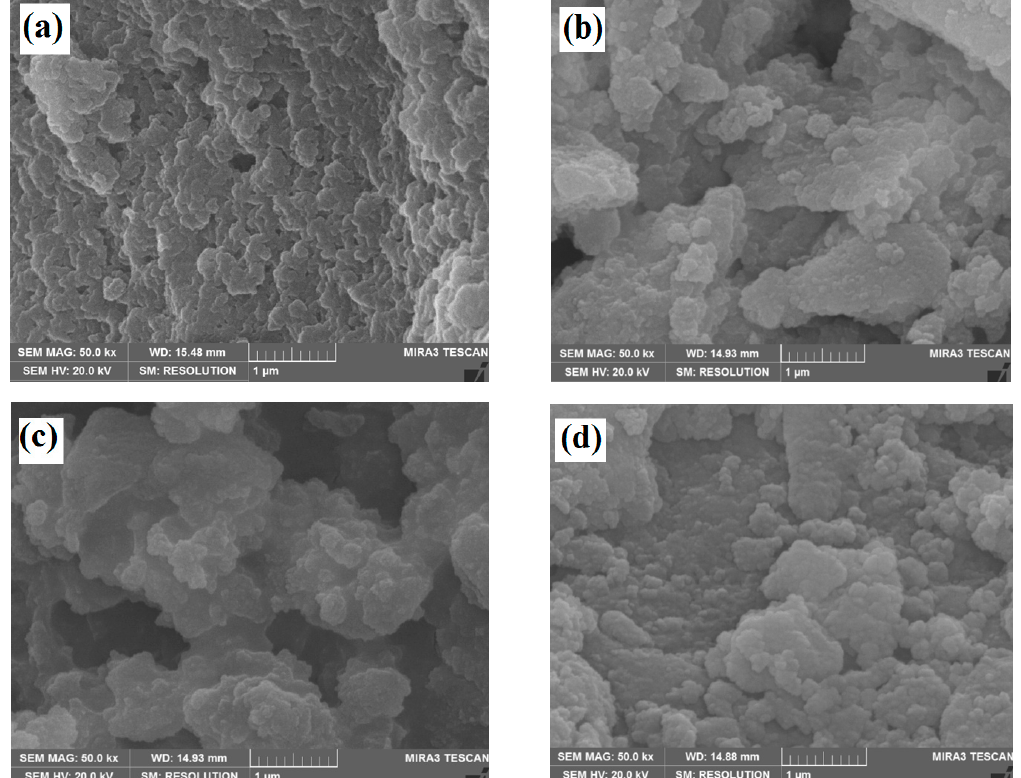
Figure 2. SEM images of the resin before ( a ) and after ( b ) La(III) or ( c ) Ce(III) or ( d ) Y(III) adsorption.